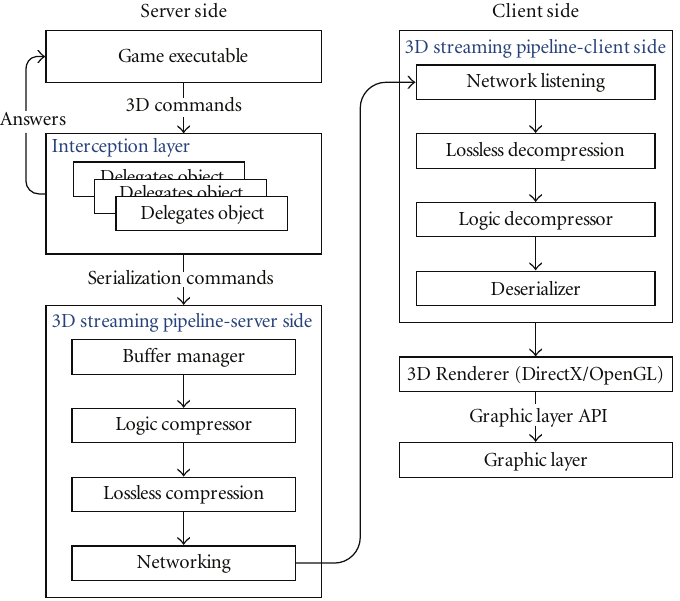
Figure 2: 3D Streaming—detailed block diagram.